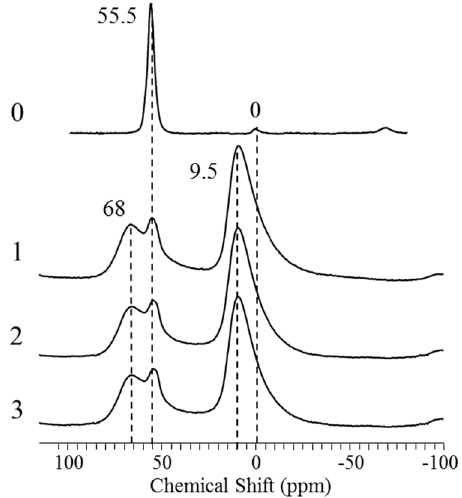
Figure 2. 27 Al MAS NMR spectra for HZSM-5 / Al 2 O 3 , Zr-, and Mg-modified samples. 0—zeolite